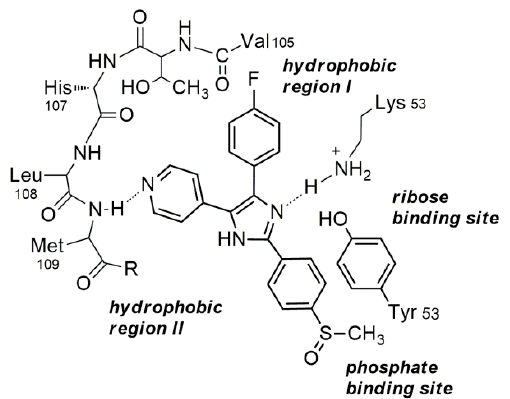
Figure 4. Binding mode of SB 203,580 at the p38 α MAP kinase ATP binding pocket.